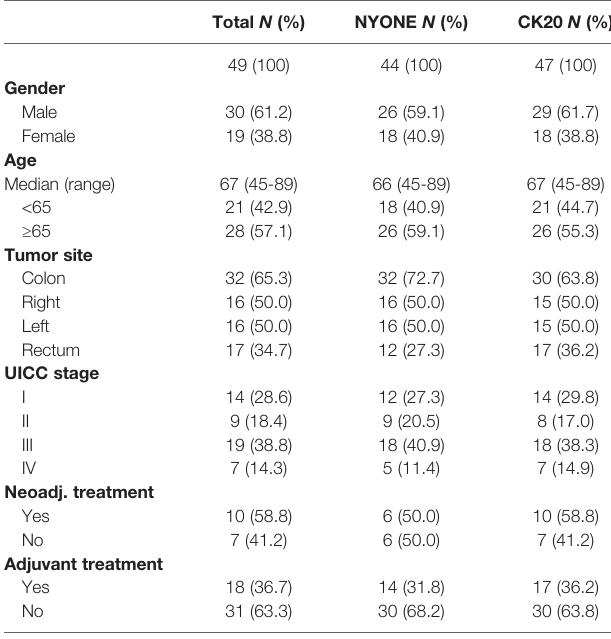
TABLE 1 | Patient demographics and clinical characteristics of the entire study population and further breakdown according to the utilized detection